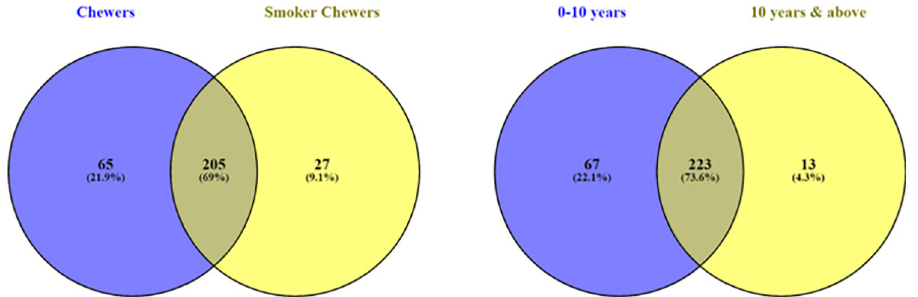
Fig 6. a. Genus-level oral microbiome Unique OTU elements composition of (Associated-Substance Grouping): Betel quid Chewers Vs. Smoker Chewers; b. Chewing History interval: 0–10 years, and 10 years-above chewing exposure time in years.